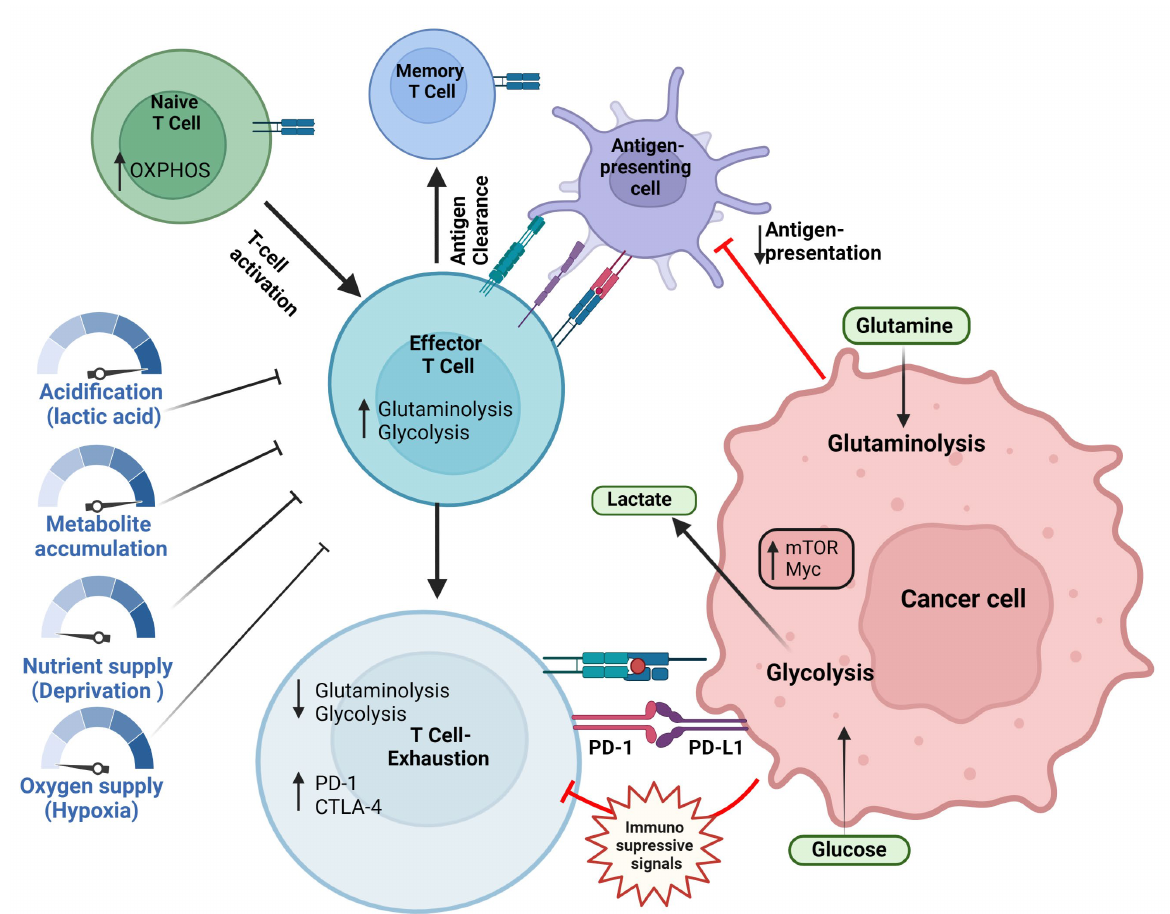
Figure 2. Naïve T-cells relay on oxidative metabolism. After activation, the effector T-cells increase glycolysis to support their function. On antigen clearance, the effector T-cells enter a memory state. On antigen persistence, as with long-term tumor elimination, inhibitory receptors such as PD-1 and CTLA4 reprogram the T-cell metabolism leading to metabolic impairments. Exhausted T-cells show reduced glycolysis and glutaminolysis and dependence of fatty acid oxidation. The low levels of oxygen, high levels of lactate, and the high competition for glucose potentially contribute to T-cell dysfunction in the tumor microenvironment. The image was created using Biorender app.